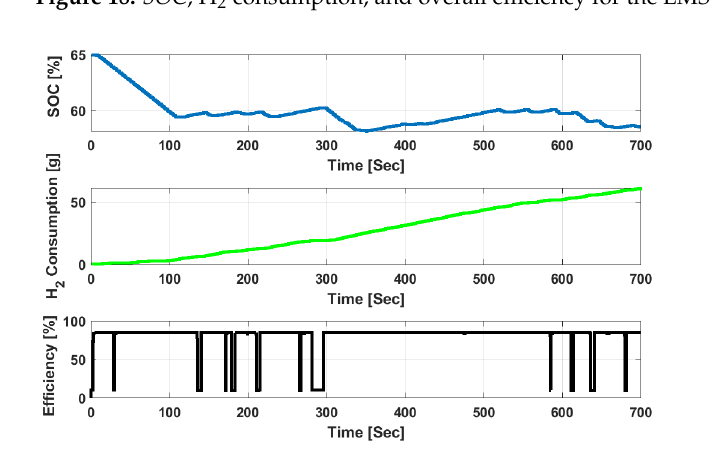
Figure 18. SOC , H 2 consumption, and overall efficiency for the EMS based on the ECMS.